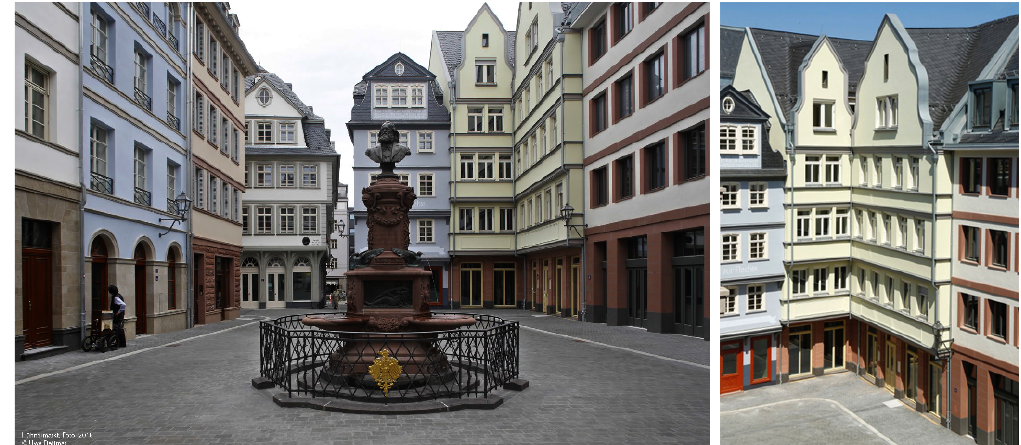
Figure 20. Frankfurt am Main: The new Dom-Römer district. Source: Sturm & Cachola Schmal